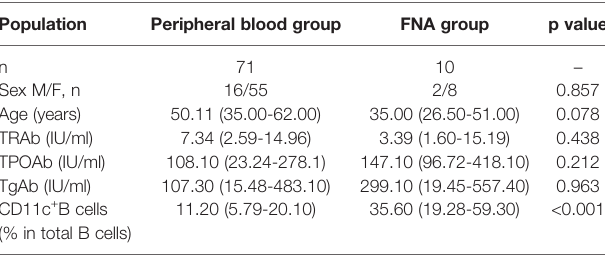
TRAb, anti-thyrotropinreceptor antibody;TgAb,anti-thyroglobulin antibody;TPOAb,anti- thyroid peroxidase antibody. The thyroid autoantibodies in the two groups of participants are presented as serum concentrations. NonnormallydistributeddataareexpressedasthemedianandIQR.Thecountingdatawere analyzed by a chi-square test. Continuous variables with nonnormal distributions were assessed with Mann – Whitney U tests. P < 0.05 was considered statistically signi fi